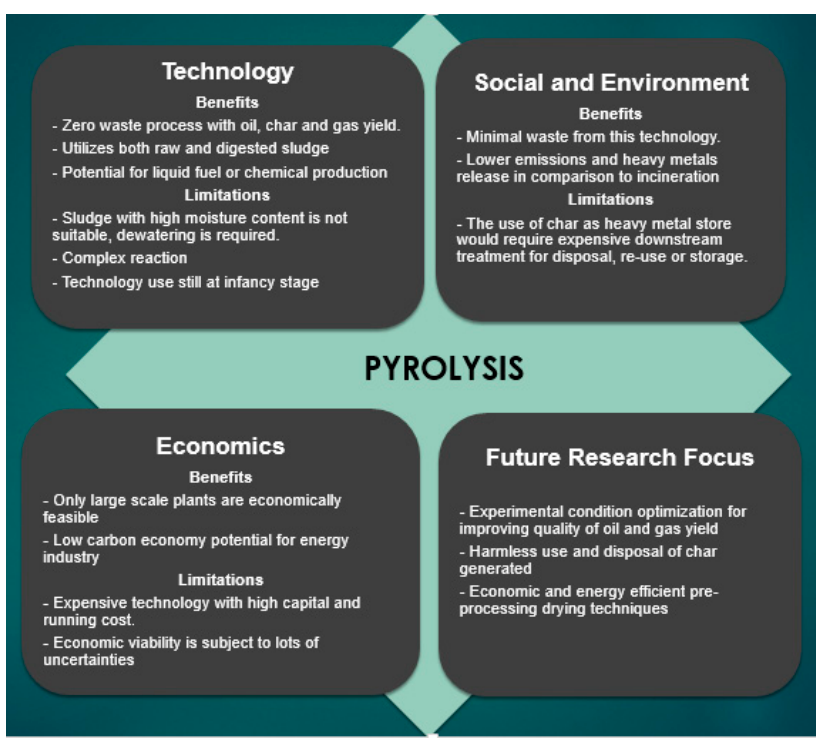
Figure 8. Technological, Socio-environmental and Economic Assessment of Pyrolysis for Sludge Processing.